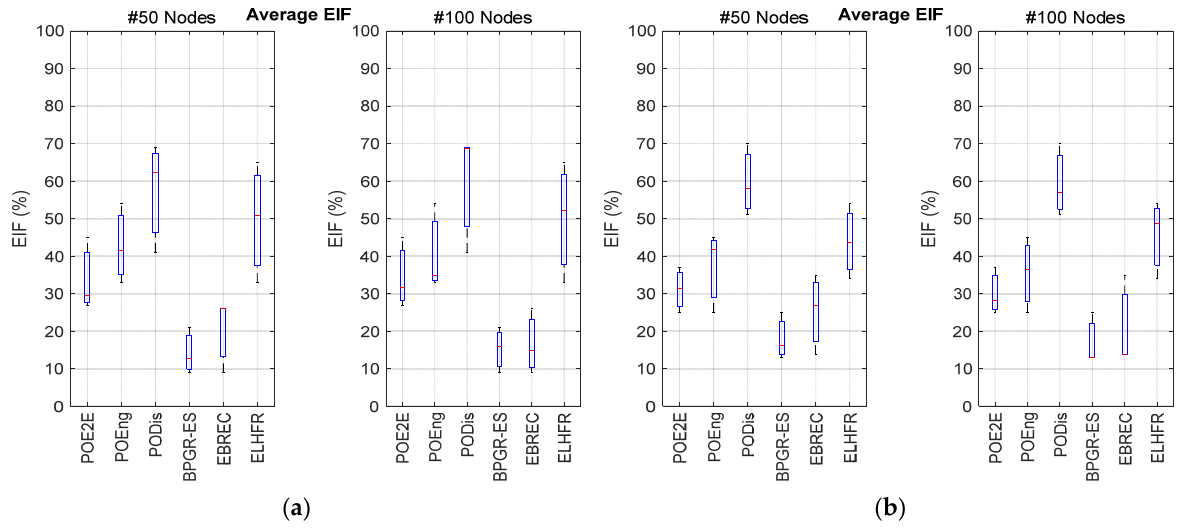
Figure 6. Average of energy imbalance factor for different topologies: ( a ) average EIF results of the 100 × 100 m 2 network area of 50 and 100 sensor nodes; ( b ) average EIF results of the 200 × 200 m 2 network area of 50 and 100 sensor nodes.